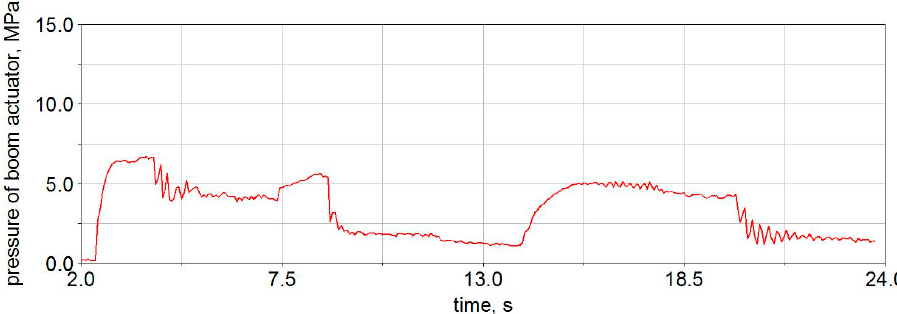
Figure 16. Plot of boom cylinder pressure for manipulator with counterbalance valves and effector velocity 300 mm/s.